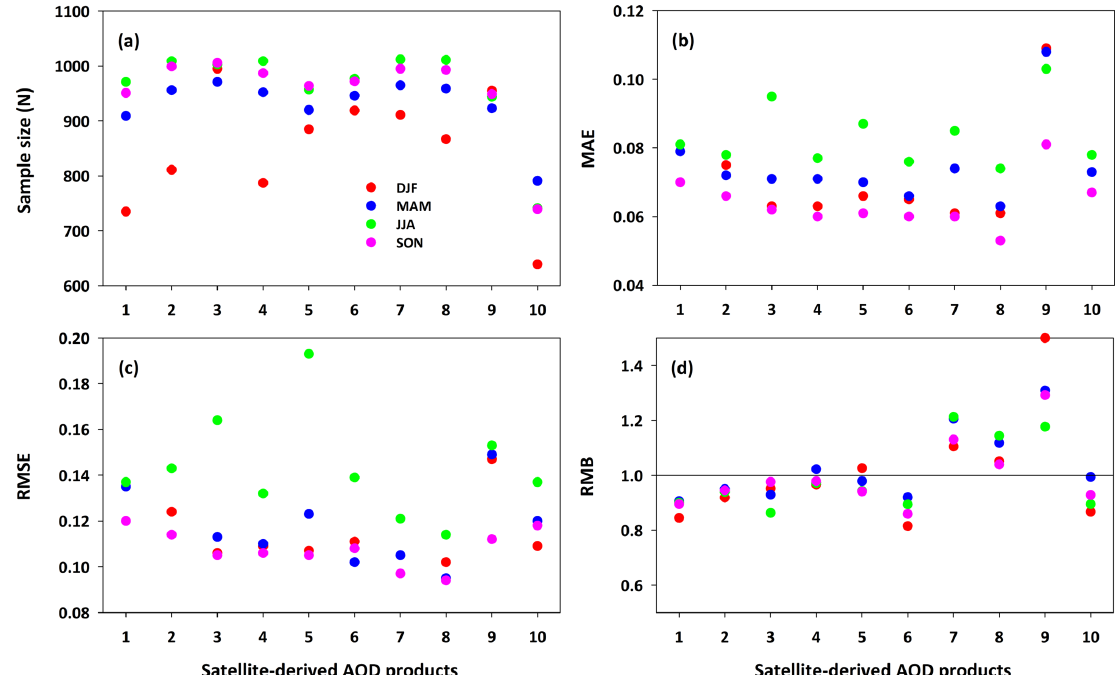
Figure 12. Seasonal performance for satellite-derived AOD S against AERONET AOD A measurements from 2006 to 2010 in terms of (a) sample size ( N ), (b) MAE, (c) RMSE, and (d) RMB, where numbers 1–10 on the x axis represent the AATSR-ADV, AATSR-EN, AATSR-ORAC, AATSR-SU, AVHRR, MISR, MOD08, MYD08, POLDER, and SeaWiFS